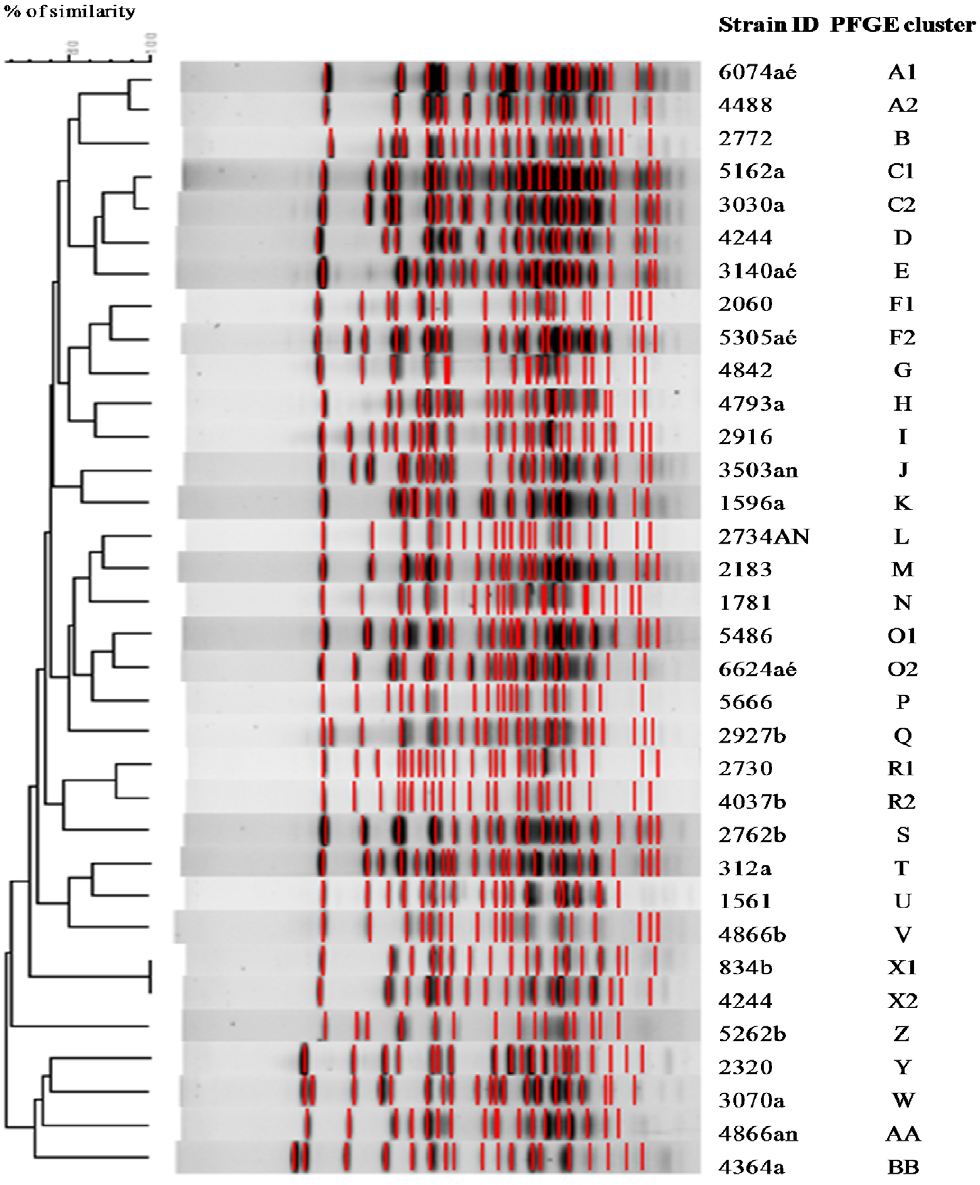
Figure 1. PFGE profiles after XhoI digestion of methicillin-resistant S.hominis isolates. The dendrogram showing the clustering of strains was performed by analysis of PFGE profiles with the Bionumerics software, with 1% tolerance and 0.8% optimization (this study). Clusters were defined at a cut-off value of 90%.